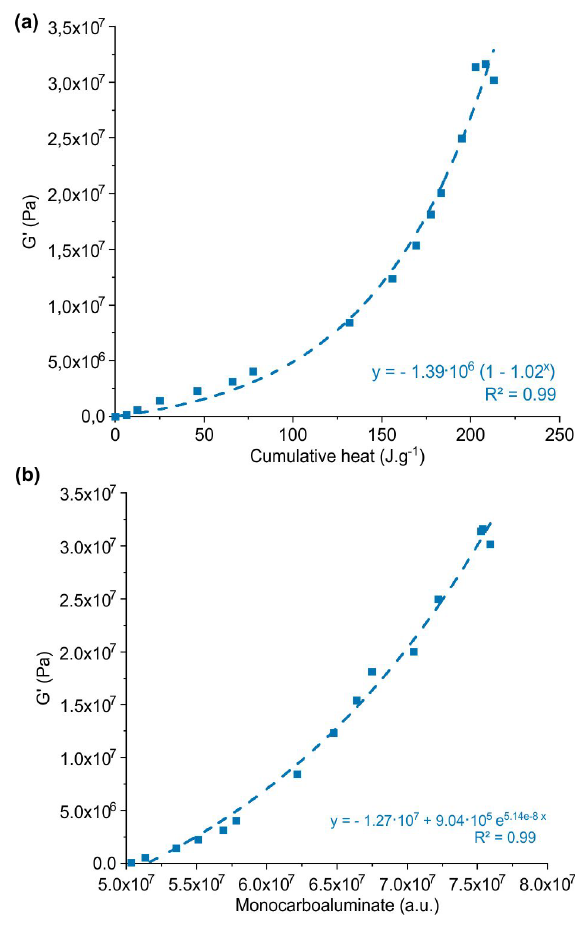
Figure 10. G' as a function of cumulative heat (a) and monocarboaluminate WAXS intensity